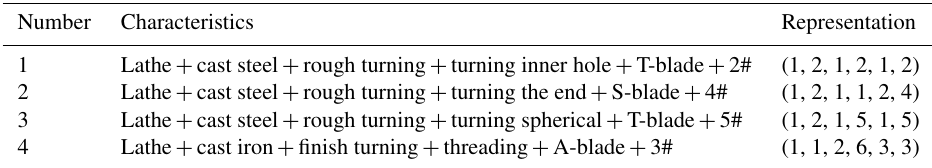
Table 2. Target domain sample set (Expert experience sample set).